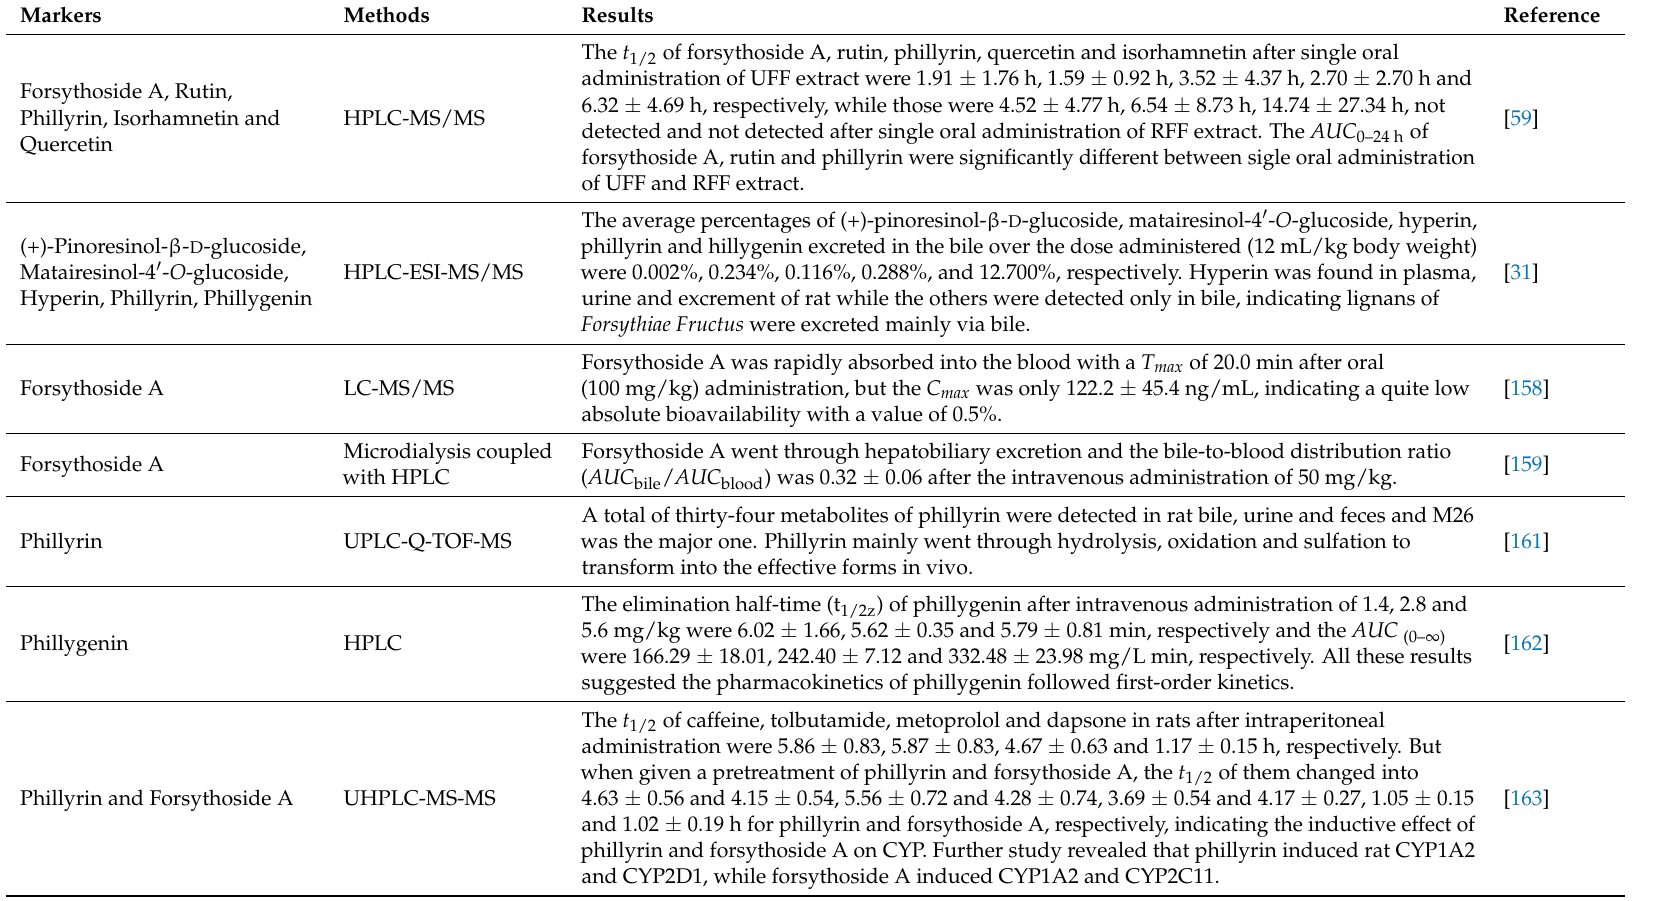
Table 4. The investigations about pharmacokinetics of Forsythiae Fructus